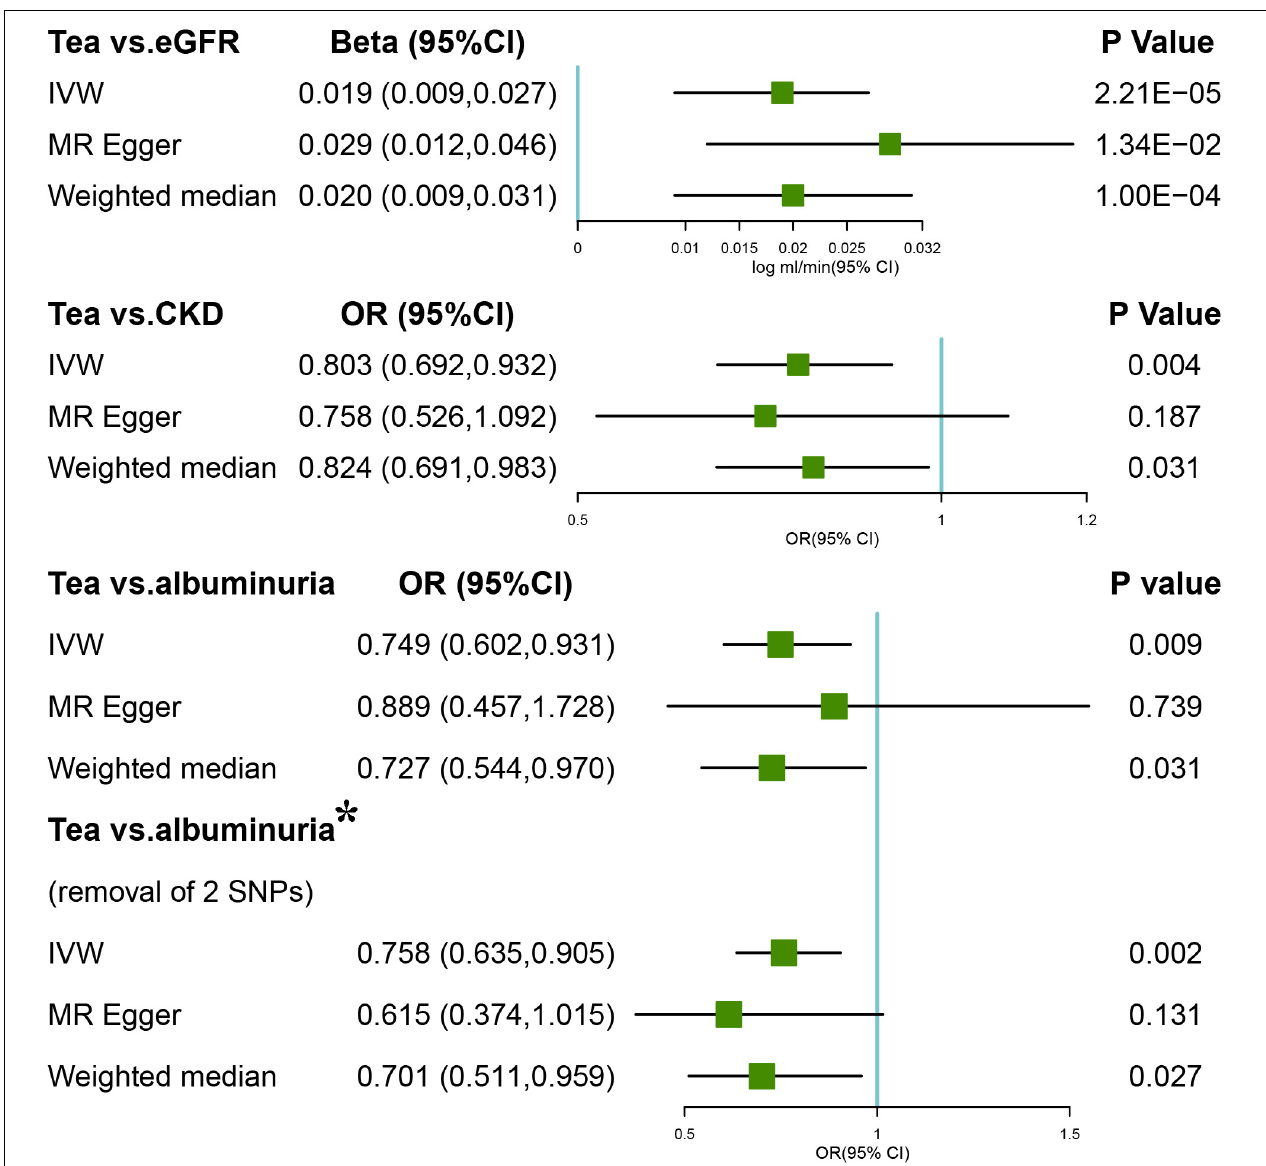
FIGURE 1 | Forest plots of Mendelian randomization (MR) study using genetically predicted tea consumption with chronic kidney disease (CKD), glomerular filtration rate (GFR), and albuminuria. Inverse-variance-weighted (IVW), MR-Egger, weighted median, simple, and weighted mode were used in this study. *Denotes the removal of two single-nucleotide polymorphism (SNPs; rs1030510 and rs4410790) that might give rise to significant heterogeneity (MR-Egger intercept p =